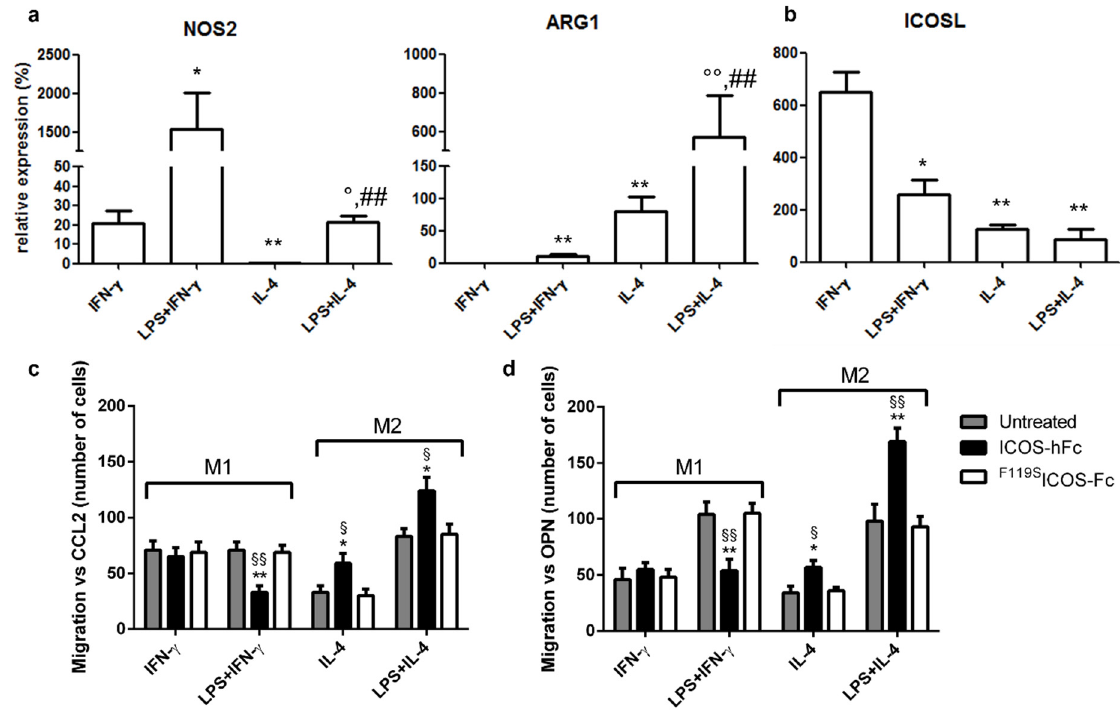
Figure 6. Effect of ICOS-Fc on the migration of murine M1 and M2 macrophages. Macrophages obtained by culturing adherent spleen cells with M-CSF for 14 days (M0) were polarized to M1 or M2 macrophages by culturing them with IFN- γ or LPS + IFN- γ (M1) or with IL-4 or LPS + IL-4 (M2) for 48 h. ( a ) NOS2, ARG1, and ( b ) ICOSL gene expression analysis by real-time PCR. Values are expressed as % of the mRNA detected in M0 macrophages stimulated with LPS for 48 h (* p <0.05, ** p < 0.01 vs. IFN- γ , ° p < 0.05, °° p < 0.01 vs. IL-4, ## p < 0.01 vs. LPS + IFN- γ , Mann–Whitney test). ( c , d ) Cell migration assay. Murine M1 and M2 macrophages were cultured in the presence and absence of ICOS-hFc or F119S ICOS-Fc using either CCL2 (30 nM) ( c ) or OPN (10 µg/mL) ( d ) as chemotactic factors. Values are expressed as number of migrating cells, stimulated with either CCL2 or OPN. The results are expressed as mean ± SE from n = 3–8 experiments; differences versus either F119S ICOS-Fc (* p < 0.05; ** p < 0.01) or the untreated control ( § p < 0.05; §§ p < 0.01) for each condition are calculated by Dunnett test.